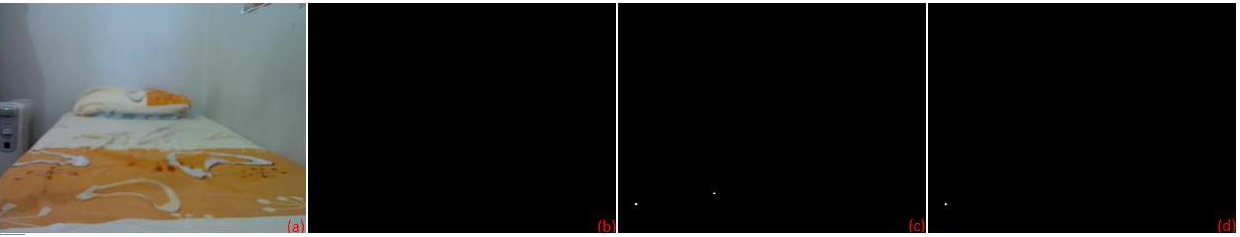
Figure 15. Simulation results for the shadow modelling comparison. ( a ) Input ( b ) Ground truth ( c ) Method: Wang ( d ) Method: Zulkifley et al